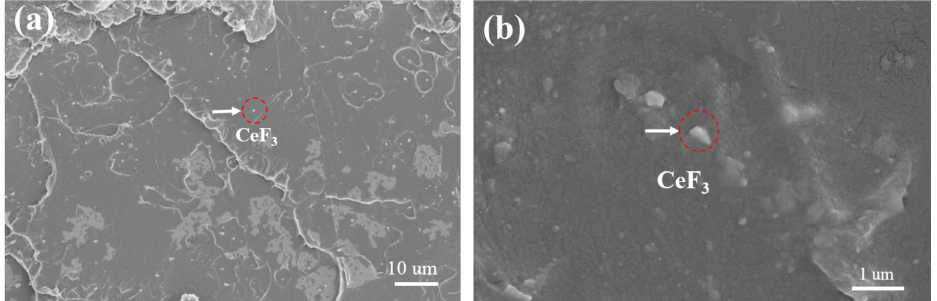
Figure 6. ( a ) Cross-section and ( b ) surface morphology of P/F2